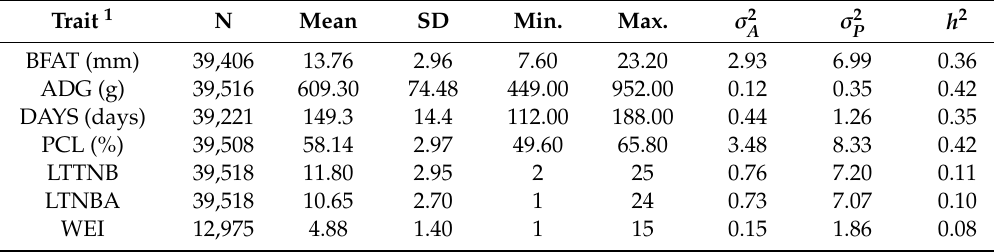
Table 1. Variance components and heritability estimated for growth and reproductive traits in Yorkshire